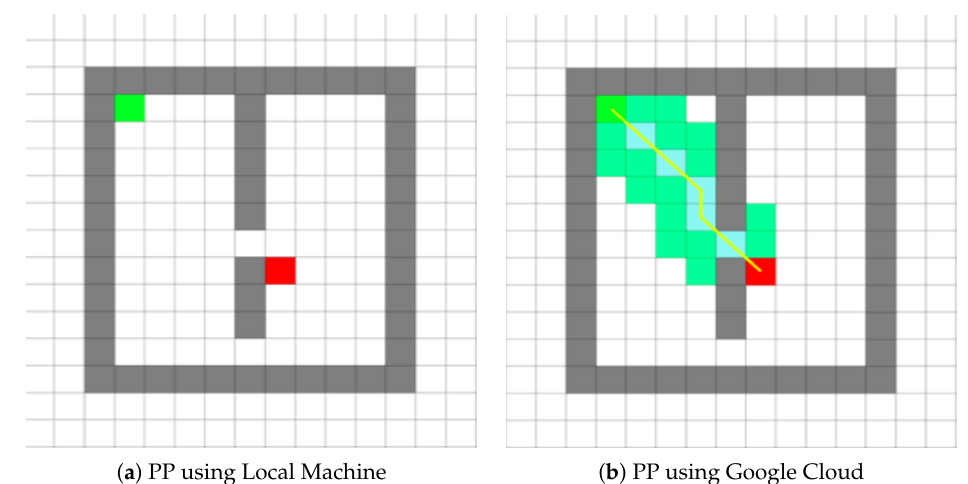
Figure 6. Output of path planning using A* Star algorithms using local machine ( a ) and Google Cloud Computing Platform ( b